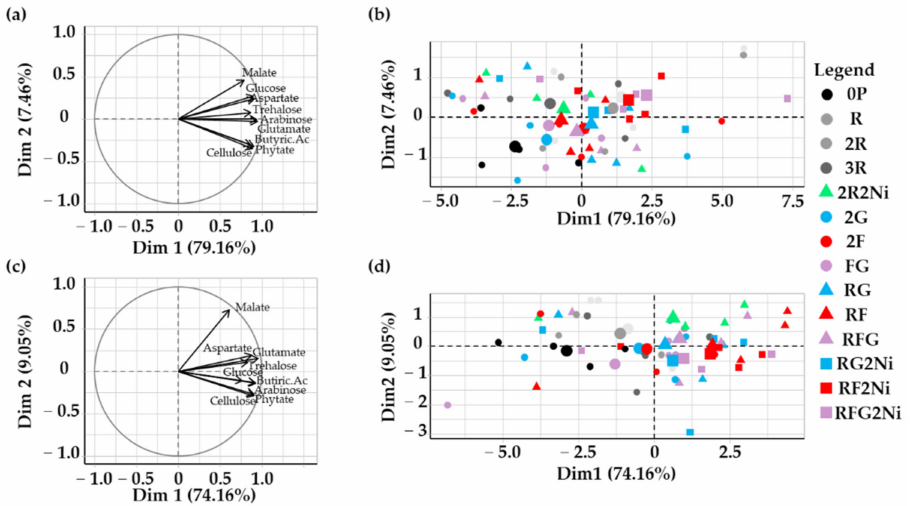
Figure 5. PCA based on SIR measurement of 12 substrates of the different treatments on the adherent soil ( a , b ) and bulk soil ( c , d ). The small points/triangle/scars represent the repetitions, and the large points represent the average of the four replicates of a treatment. R: OSR ( Brassica napus L. cv Avatar), F: Faba bean ( Vicia faba L. cv Fanfare), G: Grass pea ( Lathyrus sativus L. cv Merkur) and Ni: Niger ( Guizotia abyssinica (L.f.) Cass.). 0P: No plant. The detailed data are presented in Table